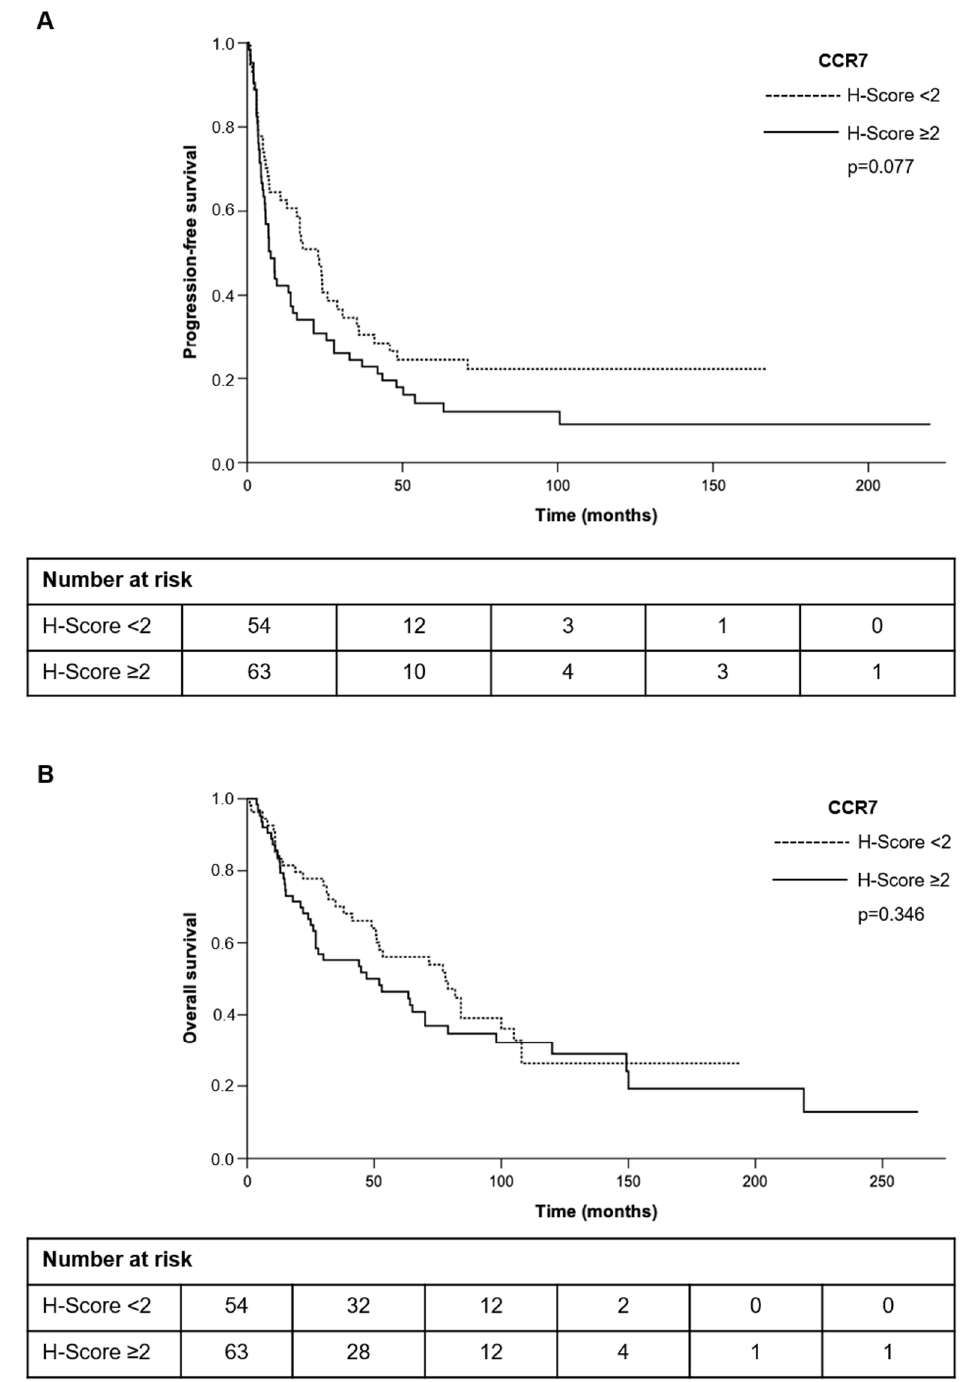
Figure 5. Progression-free survival ( A ) and overall survival ( B ) of patients with adrenocortical carcinoma influenced by CCR7 H-Score for membrane staining.